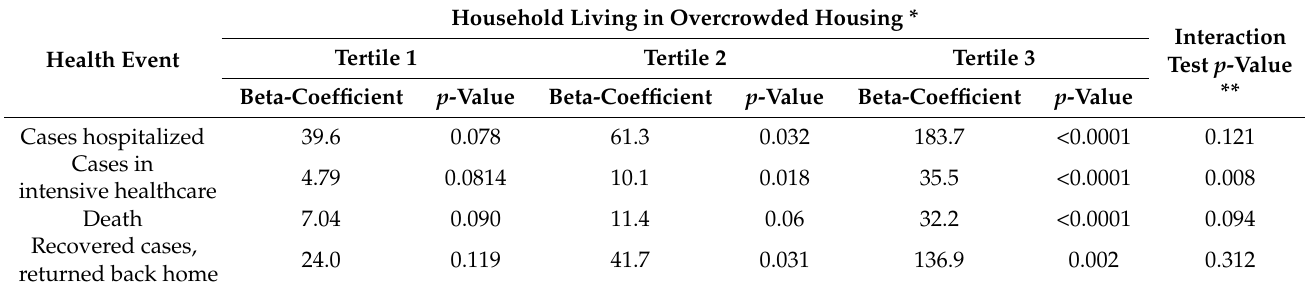
Table 2. Association between long-term NO 2 exposure (scenario 2) and COVID-19-related outcomes according to the tertile distribution of the percentage of overcrowded housing.